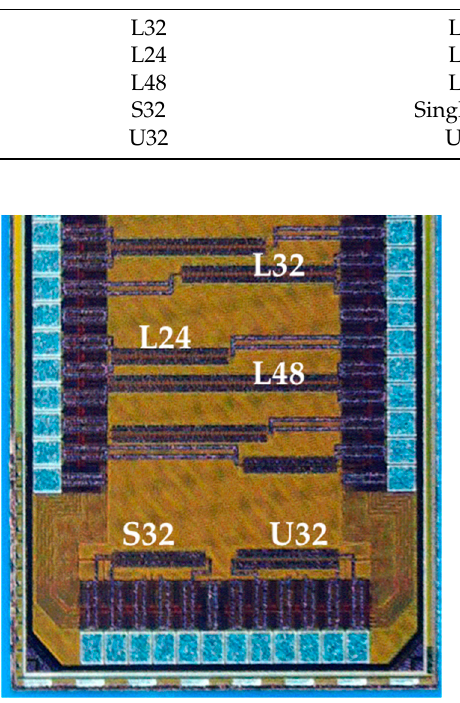
Figure 10. Die photo.